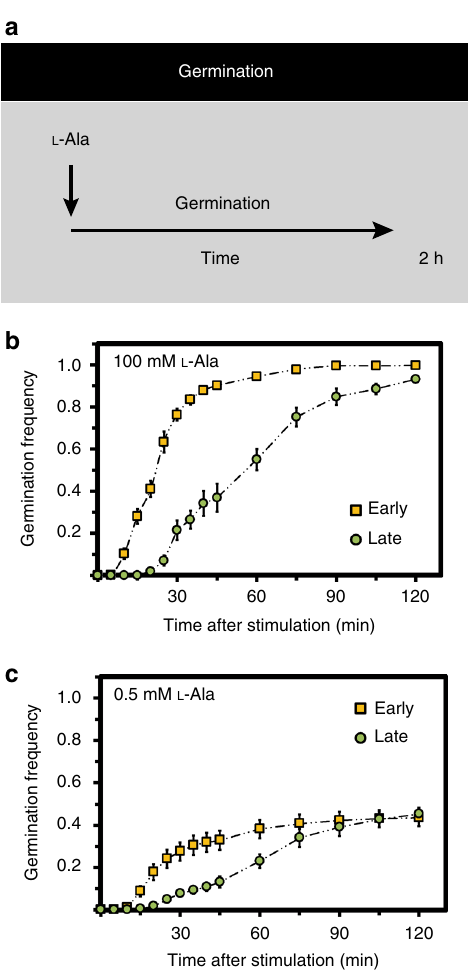
Fig. 3 Early spores germinate faster than late spore in response to the nutrient germinant L -alanine. a Germination dynamics was assessed by measuring the fraction of spores that lost refractivity as a function of time in response to the nutrient germinant L -alanine. See Methods for details. b Germination frequency of early and late spores in response to a strong stimulus and c a weak stimulus. Strain: BIB1019, data: mean ± SEM, n c = 9